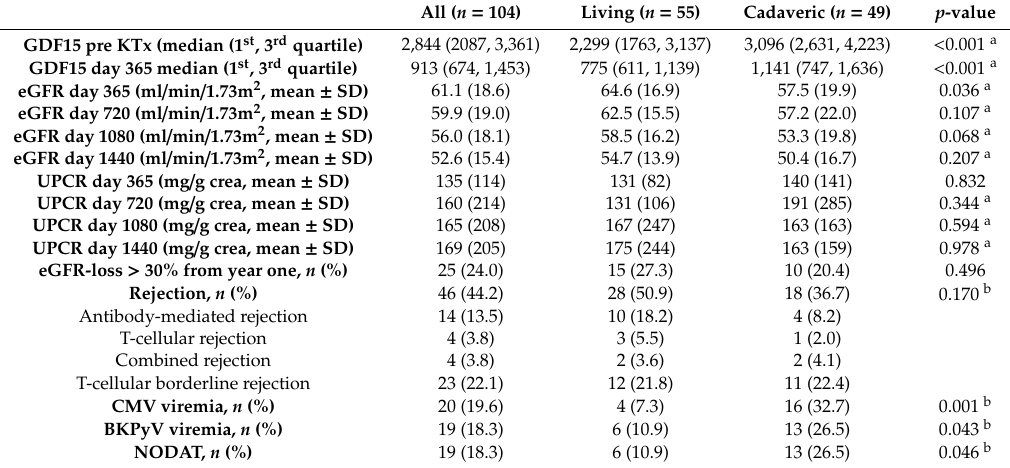
Table 2. Outcomes of the